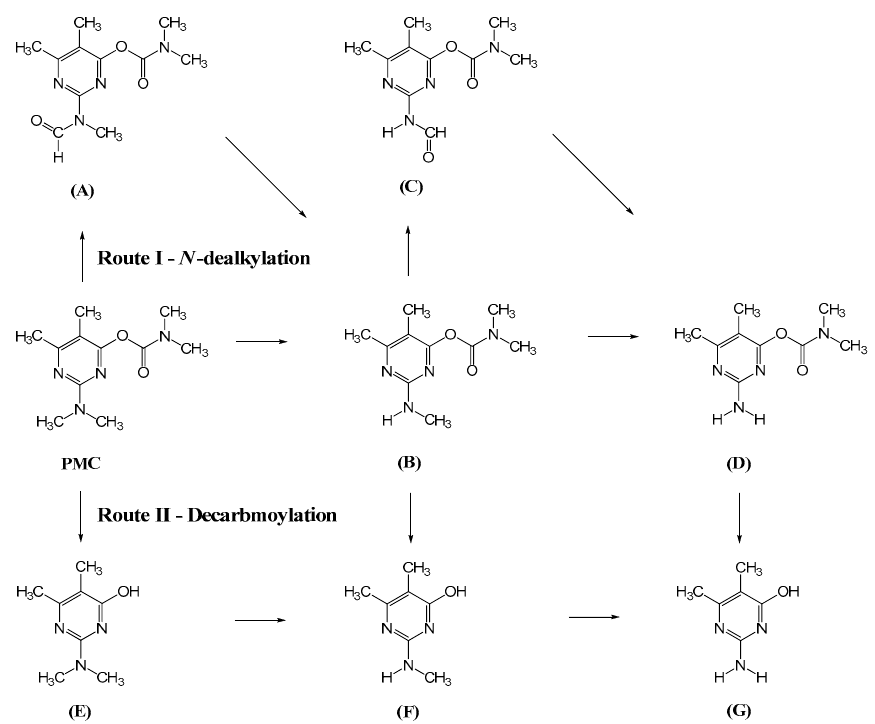
Figure 14. Proposed pirimicarb photodegradation routes after intermediate identifications.